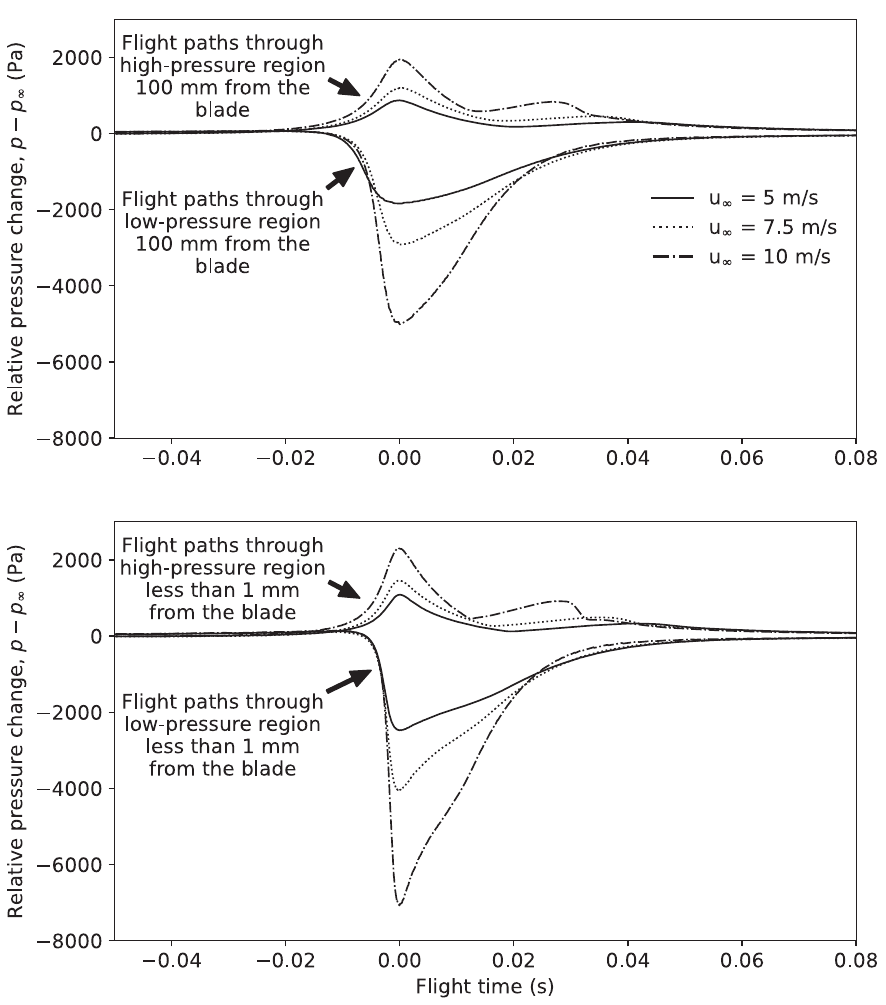
Fig 9. Pressure vs. time history for bat flight paths near the NREL 5 MW reference wind turbine blade at the 90% blade span location for wind speeds of 5 m/s, 7.5 m/s, and 10 m/s. (Top) flight paths 100 mm from the blade surface and (bottom) flight paths < 1 mm from the blade surface. Note that the pressure-time histories have been shifted to the minimum or maximum pressure that occurs at 0 s. Time before 0 seconds is when bats are approaching the peak low or high pressure, and time after 0 seconds is when bats are flying away from peak low or high pressure.